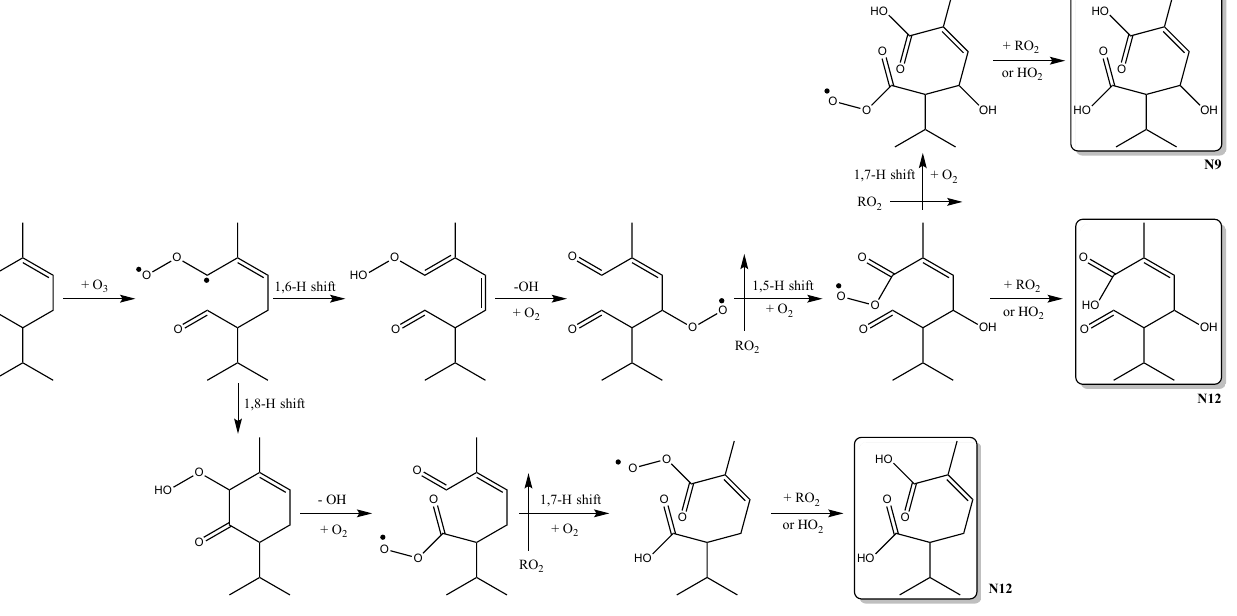
Figure 4. Formation mechanisms of compounds N9 and N12. Perpendicular arrows with RO 2 denote peroxy radical self-reactions to form an alkoxy